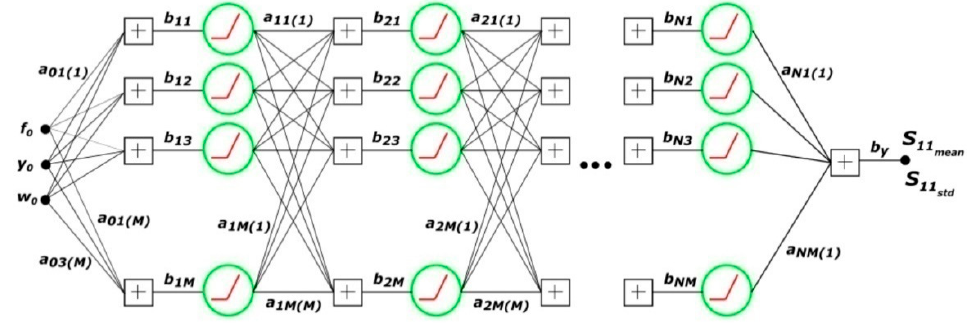
Figure 13. The structure of each ANN used to model the mean and standard deviation of the random reflection coefficient of an ordinary Patch antenna in the 24.5–28.7 GHz frequency band.